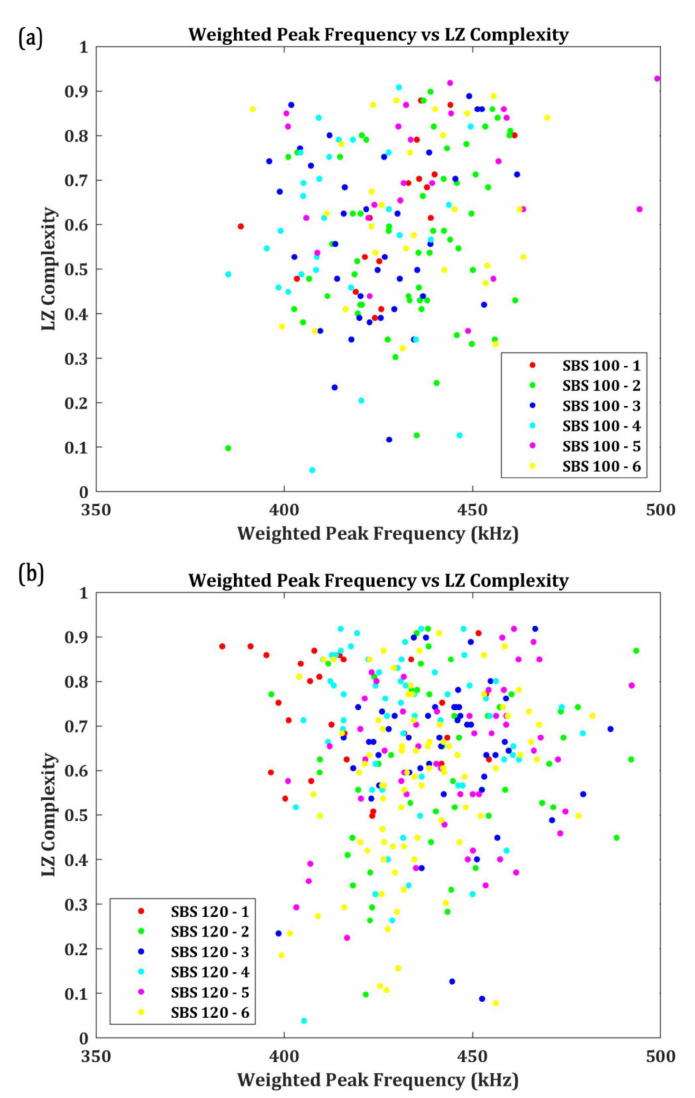
Figure 12. Weighted Peak Frequency (above 350 kHz) vs. LZ complexity of the AE signals for SBS specimens tested at ( a ) 100 ◦ C and ( b ) 120 ◦